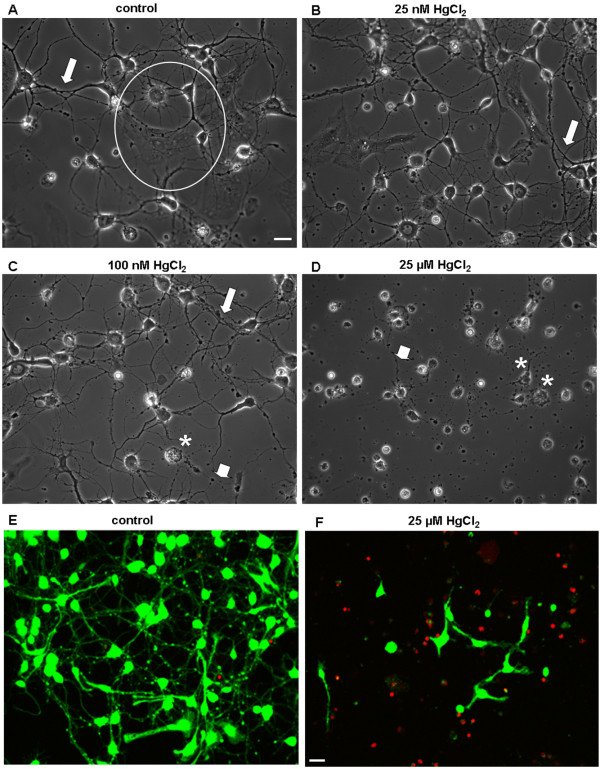
HgCl2 exposure perturbs neurite outgrowth and compromises neuronal viability in cultured cortical neurons. Rat cortical neurons were grown either in the absence (A, control) or presence of HgCl2 at 25 nM (B), 100 nM (C), and 25 μM (D) for 3 days. Phase contrast images were taken on day 3. A. Cortical culture under control conditions exhibited healthy population of neurons and glial cells (indicated by a circle), exhibiting extensive neurite outgrowth and network formulation (indicated by an arrow). B. Cells cultured in the presence of 25 nM HgCl2 also developed extensive neurite processes and formed extensive network. C. Neuronal populations cultured in the presence of 100 nM of HgCl2 underwent apoptotic cell death (indicated by an asterisk) and exhibited collapse or retraction of neurites (indicated by an arrow head). D. HgCl2 at 25 μM induced cell death (indicated by asterisks) and inhibited neurite extension and network formation (indicated by an arrow). E &F shows representative confocal images of live/dead assay of cortical neurons cultured either in the absence (E) or presence (F) of 25 μM of HgCl2 for 3 days. Live cell bodies and their neurites were stained with calcein-AM (green), whereas dead cells with compromised membranes were stained with ethidium homodimer-1 (red). Scale bars, 20 μm.